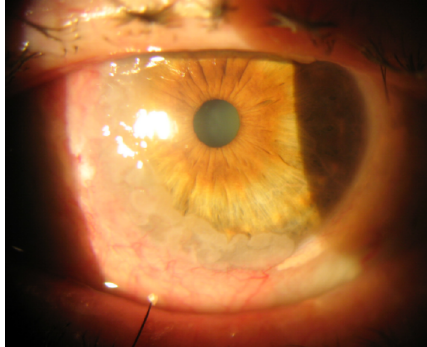
Figure 1: Slit-lamp examination; nasal limbal gelatinous mass with inferior corneal